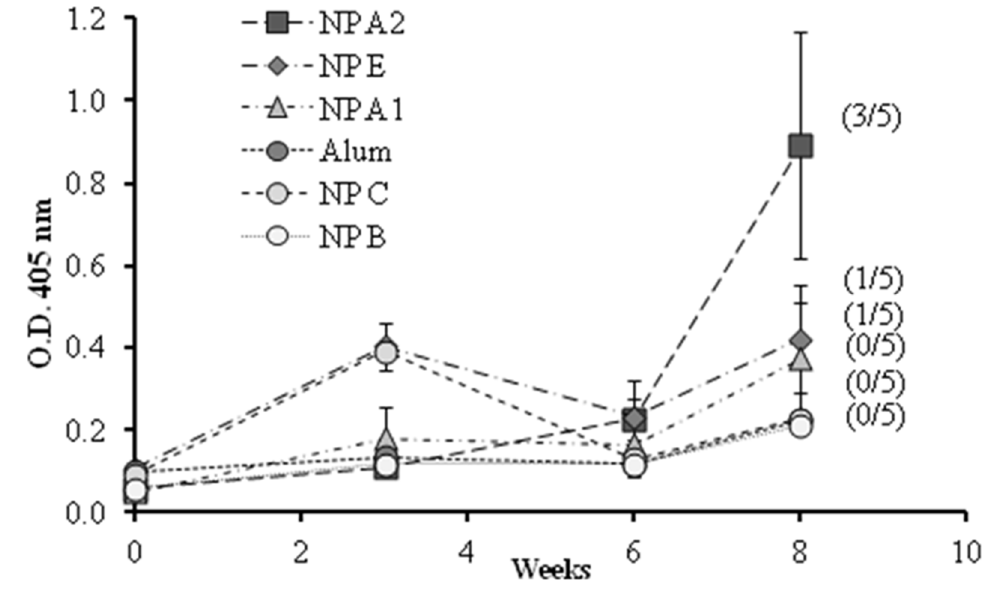
Figure 6. 1338aa peptide-specific IgG responses in diluted serum (1/50) of mice immunized with different formulations by intramuscular route. NP B: Chitosan/TPP/Poly (I:C) nanoparticles without peptides; NP C: Chitosan/TPP nanoparticles with 1338aa and PADRE adsorbed on their surface; NP A1: Chitosan/TPP/Poly (I:C) nanoparticles with 1338aa adsorbed on their surface; NP A2: Chitosan/TPP/Poly (I:C) nanoparticles with 1338aa and PADRE adsorbed on their surface; NP E: Chitosan/TPP/Poly (I:C) nanoparticles with 1338aa and PADRE encapsulated. (Number/5): Number of responsive mice in the total five mice per group. An O.D. four times higher than those of the control NP B (0.2) was considered a positive response. Results are presented as mean ± standard error of mean ( n